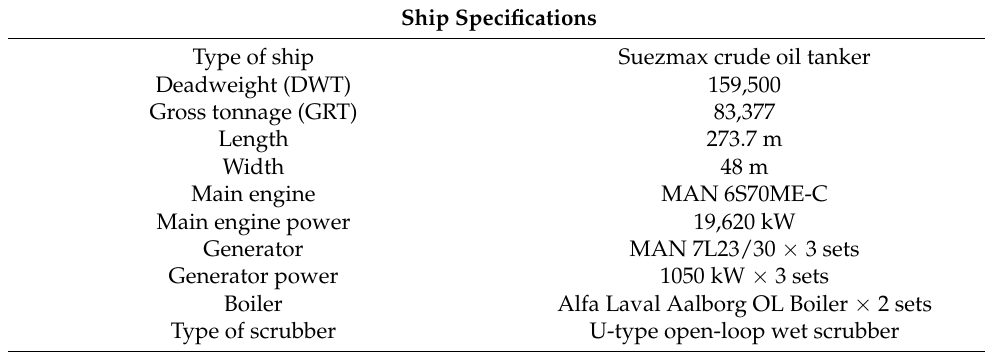
Table 3. Specifications of the ship.